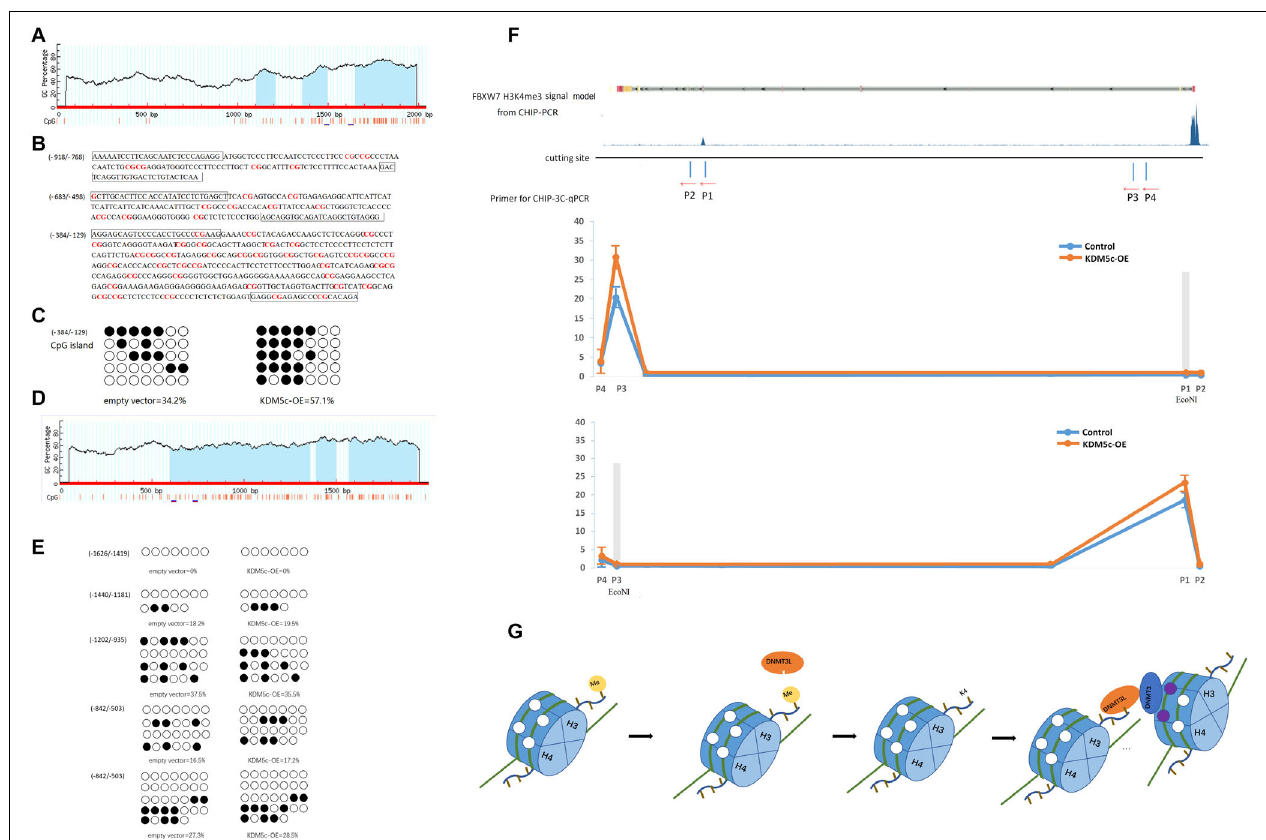
FIGURE 4 | KDM5c overexpression modifies the DNA methylation profile of the FBXW7 gene and its potential regulation. (A) Schematic representation of the FBXW7 promoter. The FBXW7 gene is located on chromosome 4, and a 2-kb promoter region spans from 152324318 to 152326358 (NCBI accession NG_029466). The GC percentage is indicated by blue background. The x -axis denotes the bp position in the 5 (cid:48) -untranslated region relative to the TSS. (B) Sequence of the CpG islands of the FBXW7 gene. The methylation loci are marked in red letters and the primer annealing positions are boxed. (C) The percentages of (384/129) CpG islands were analyzed using QUMA software. (D) Schematic representation of the c-Jun promoter. The c-Jun gene is located on chromosome 1, and a 2-kb promoter region spans from 58778791 to 58780791 (NCBI accession NC_000001.11). The GC percentage is indicated by. The x -axis denotes the bp position in the 5 (cid:48) -untranslated region relative to the TSS. (E) The percentages of c-Jun CpG islands were analyzed using QUMA software. (F) The relative association between the (384/129) CpG islands and the H3K4me3 peak interacting with KDM5c was detected by ChIP-3C-qPCR assays in RKO cells. The upper panel shows the H3K4me3 of the FBXW7 ChIP-seq signal in ENCODE, the Eco NI cleavage site, and the locations of primers used for ChIP-3C-qPCR assays. The lower panel shows the qPCR results. (G) Schematic figures showing how KDM5c adjusts the methylation of distant CpG